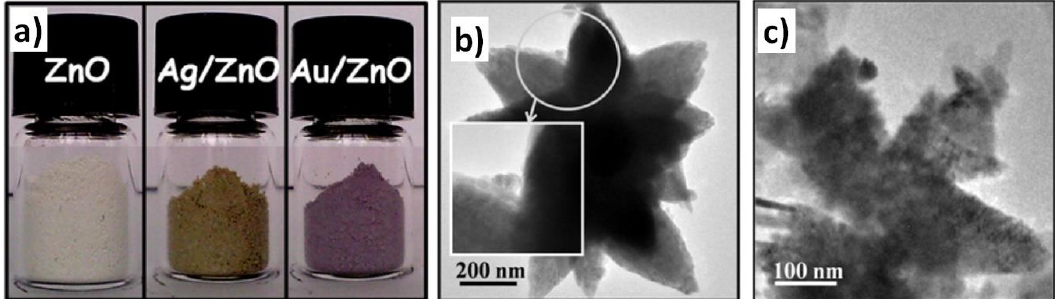
Figure 68. Photographs ( a ) of (Au, Ag)/ZnO nanocomposites; TEM images of Ag/ZnO nanostructures ( b ) and Au/ZnO nanostructures ( c ). Products synthesised by the microwave and ultrasonic wave combined method. Reprinted from [887], Copyright (2011), with permission from Elsevier [OR APPLICABLE SOCIETY COPYRIGHT OWNER]. All rights reserved. In order to re-use permission must be obtained from the rightsholder.